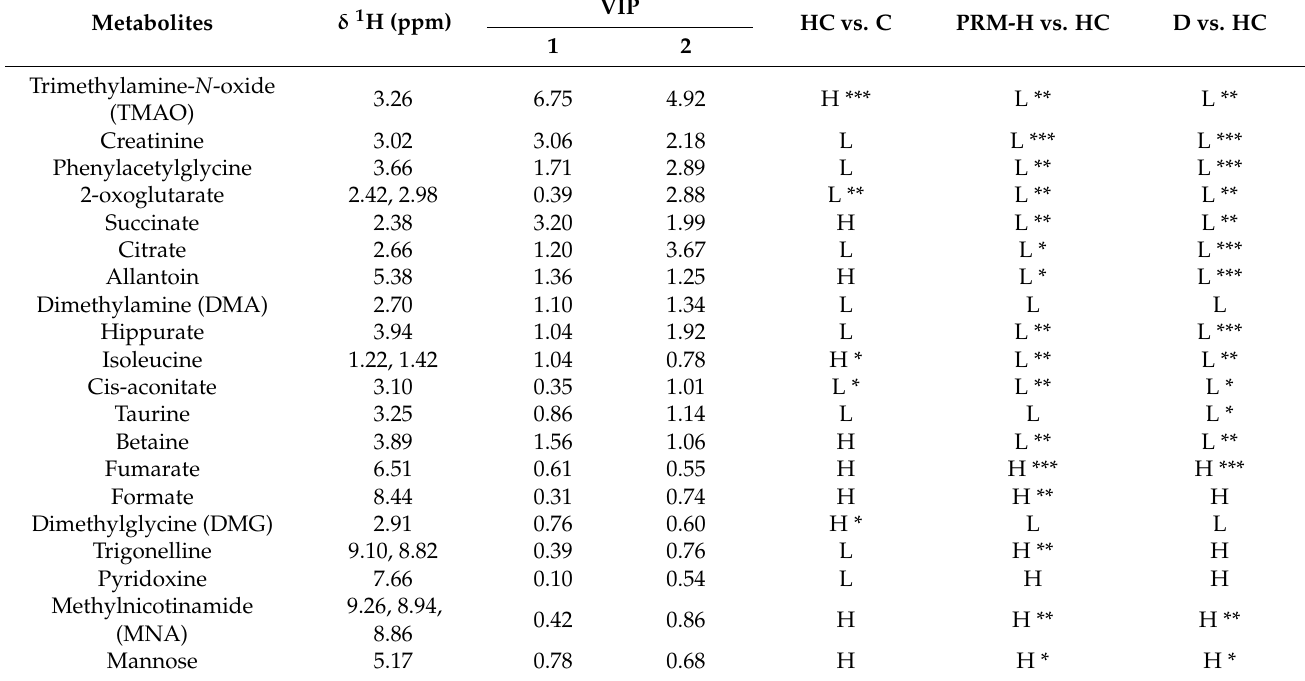
Table 3. Relative quantification of metabolites level based on binning spectral data of 1 H NMR in control (C), hyperlipidemia (HC), polyphenol-rich mixture high dose (PRM-H) and simvastatin (D) groups.